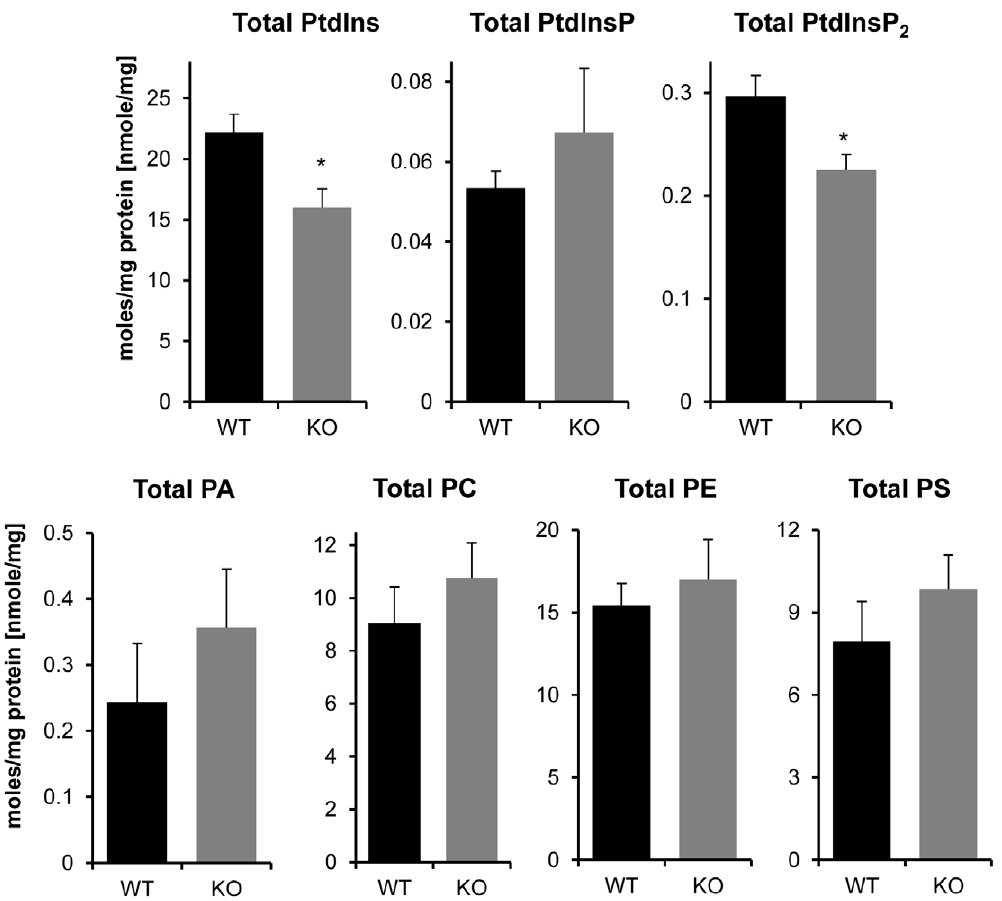
Figure 4. Effect of LPIAT1 knockout on total levels of liver phospholipids and phosphoinositides. Quantitated targeted molecular species of phosphoinositides PtdIns, PtdInsP and PtdInsP 2 in LPIAT1 + / + (WT) or LPIAT1 2 / 2 (KO) liver samples presented in Figure 3, and phospholipids PA,PC,PE and PS from Figure 2 were added to calculate total levels for each lipid. Data are mean 6 SD, n=4 for both WT and KO. *p # 0.05, T-test.